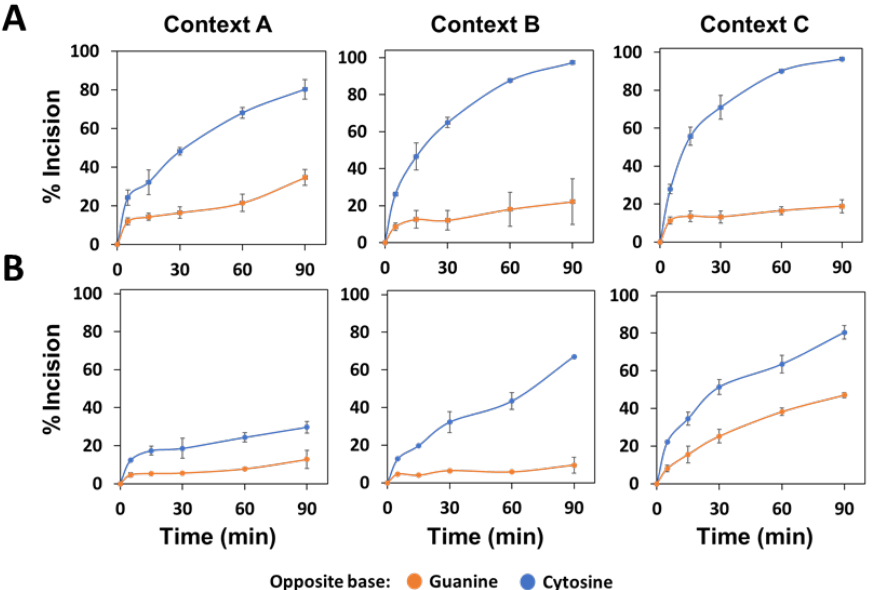
Figure 5. Effect of sequence context and base opposite the abasic site on the AP lyase activity of recombinant FPG. His-FPG protein (2 nM) was incubated at 37 °C with 20 nM ( A ) or 40 nM ( B ) of DNA substrates (contexts A, B or C) containing an AP site opposite guanine (orange) or cytosine (blue). After stabilization with NaBH 4 , reaction products were separated by denaturing PAGE, detected by fluorescence scanning and quantified. Data are the mean and standard error from three independent experiments.